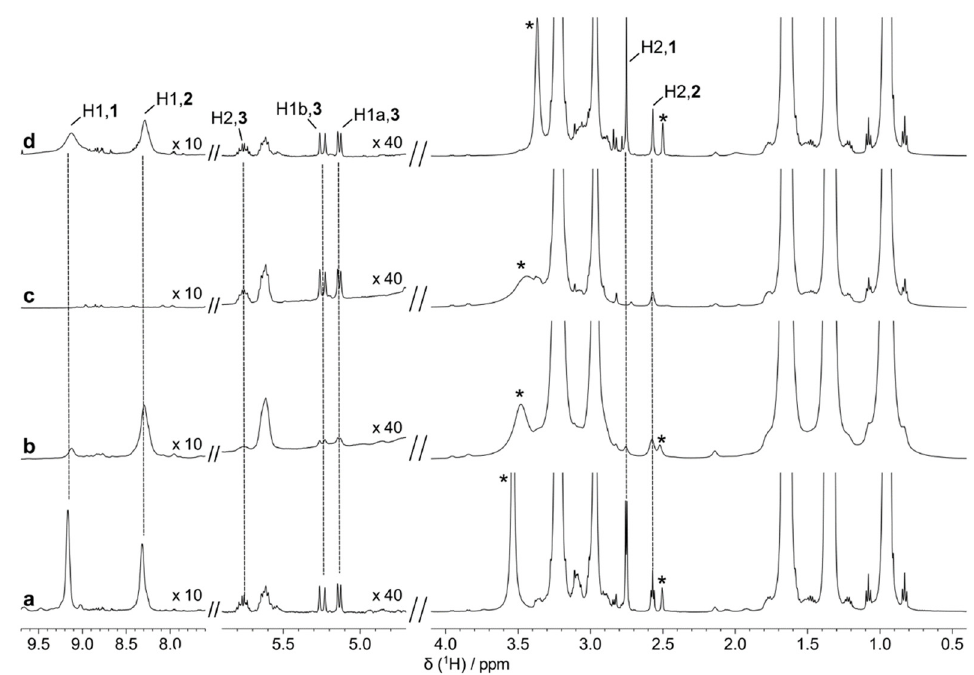
Figure 8. Expansions of 1 H HRMAS NMR spectra of 4B168 ( a ), 1B168 ( b ), 2B168 ( c ), and 3B168 ( d ). Expansion factors are reported for each region. Selected signals of the degradation compounds are labeled using the same notation as that applied in Figure 5. Water (3.3–3.6 ppm) and residual DMSO- d 5 (2.50 ppm) signals are marked with asterisks.